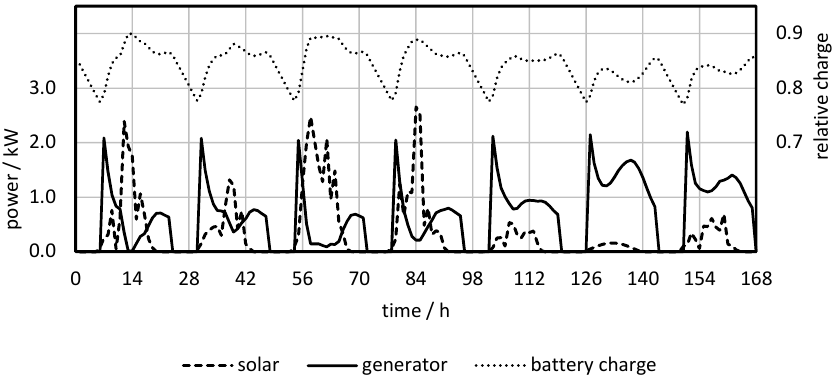
Figure 12. Power production and charge on the batteries for the SOPE for 1 week.